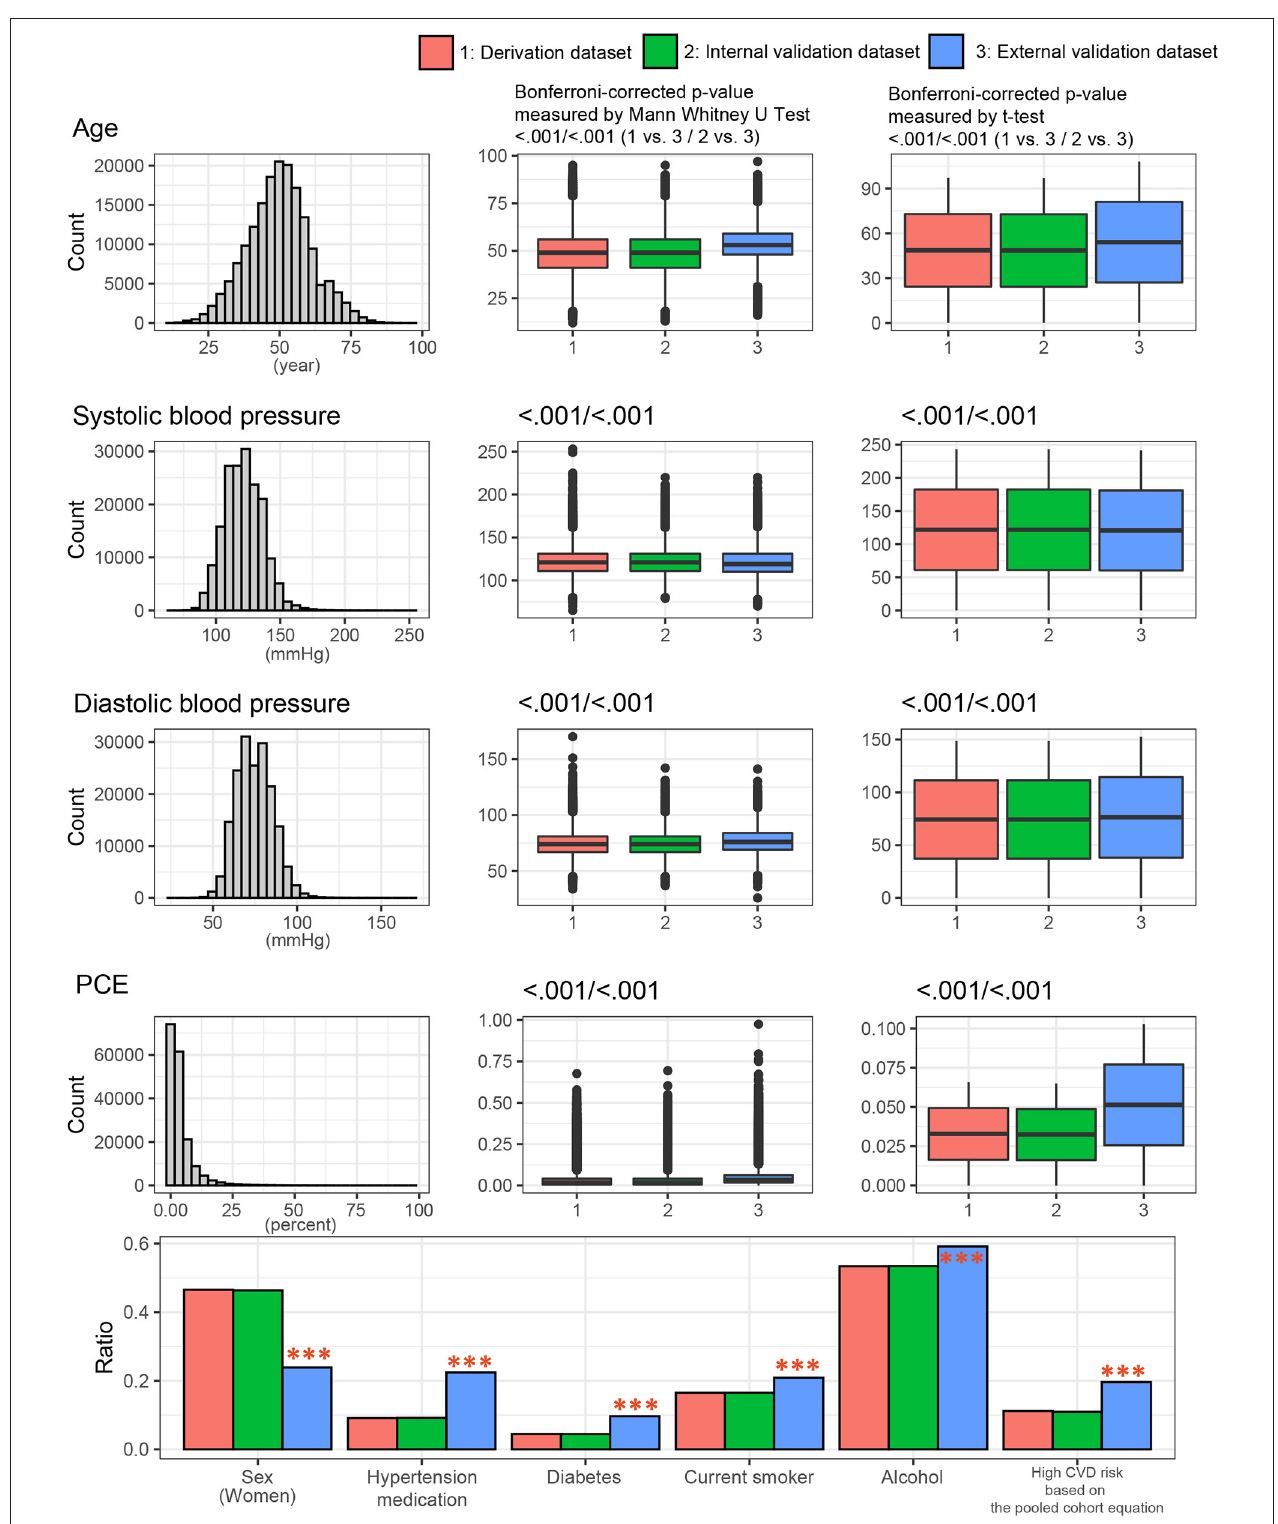
FIGURE 3 | Clinical characteristics of the study population among the three datasets. P values were calculated using the t -test and Mann-Whitney U test for continuous variables or the chi-square test for categorical variables. *** p < 0.001. PCE, pooled cohort equations.